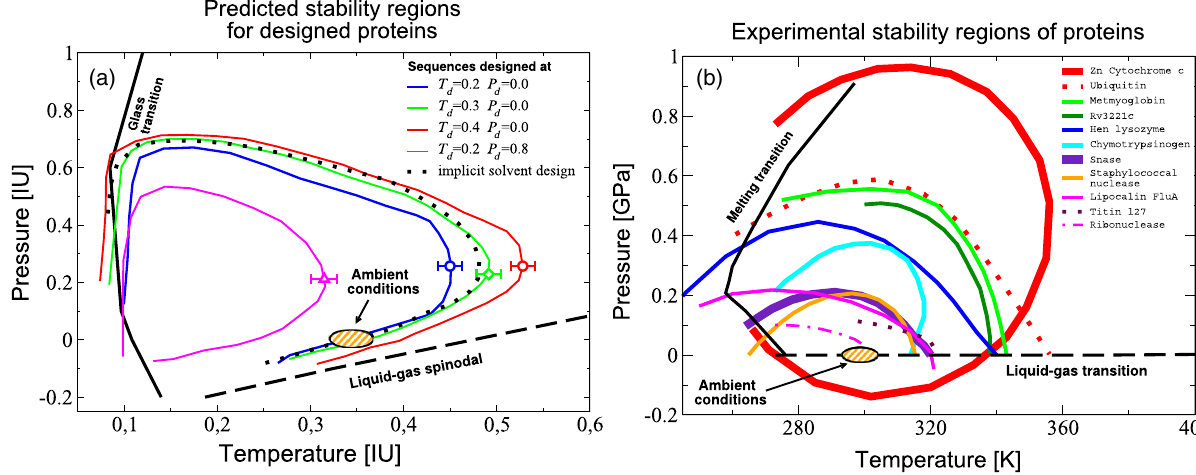
FIG. 1. T – P stability regions of designed and experimental proteins. (a) Average stability regions (closed curves) within which the protein sequences designed with the MIN ENTHALPY protocol at different T d and P d fold into the native state. The regions for proteins designed at P d ¼ 0 (red, green, and blue curves), close to ambient pressure, are enclosed one into another with an extension that is proportional to T d . All of these regions enclose the stability region of proteins designed at higher P d (pink curve). The dotted line shows the stability region for a sequence calculated with the IMPLICIT SOLVENT protocol. The “ glass-transition ” (solid black) line defines the temperatures below which the system does not equilibrate. The long-dashed line represents the limit of stability (spinodal) of the liquid with respect to the gas phase. Pressure and temperature are expressed in internal units (IU). (b) Experimental stability region for different proteins indicated in the legend (adapted from Refs. [40 – 49]). The long-dashed line is the liquid-gas transition line. The data show a clear positive correlation between the T range and P range of stability. Pressure denaturation is observed in a range of − 0 . 1 ≲ P= GPa ≲ 0 . 6 , while stability at higher P is reached by introducing artificial covalent bridges between the amino acids, as in the case of Zn cytochrome c [43]. In both panels, the shaded region corresponds to ambient